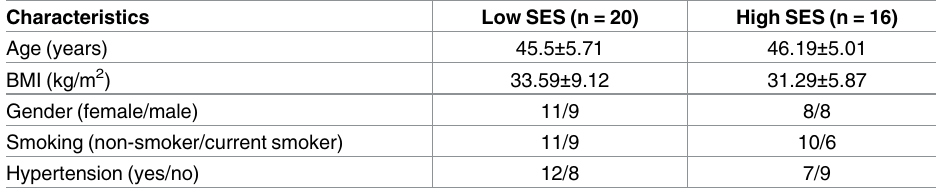
Table 1. Baseline characteristics of the samples included in the